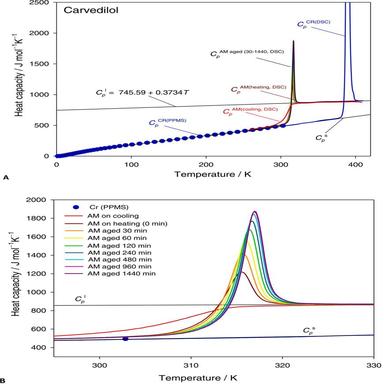
Experimental heat capacity of (A) crystalline (Cp CR(DSC), Cp CR(PPMS)) and amorphous on heating (Cp AM(heating, DSC)), on cooling (Cp AM(cooling, DSC)) and aged from 30 to 1400 min (Cp AM aged(30–1400, DSC)) carvedilol, obtained by PPMS and DSC in the frame of calculated heat capacity in the solid (Cp s ) and liquid (Cp l ) states. In plot (B), the glass transition region, which is overlapped on plot A (Cp AM aged(30–1400, DSC)) is presented, showing unaged and aged amorphous phases of carvedilol.